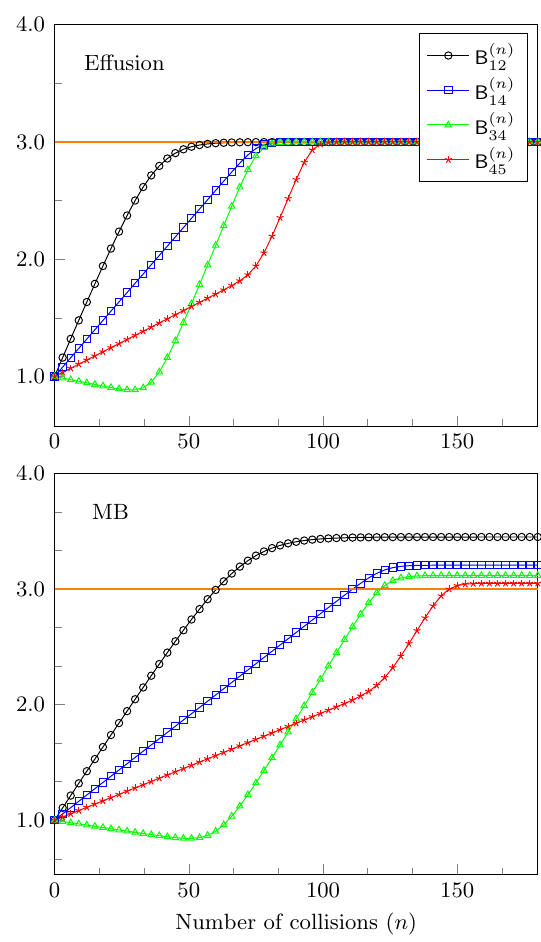
FIG. 6. Evolution of ρ ( n ) when the state of X is a mixture of Y broad Gaussian wave packets weighted with the effusion distribu- FIG. 5. Plot of B ( n ) defined in Eq. (58) computed for an ensem- jk ble of narrow Gaussian wave packets weighted by the effusion are obtained by composing tion. Upper panel: The values (ρ Y ) ( n ) ij distribution in Eq. (45) and the Maxwell-Boltzmann (MB) distri- and (ρ Y ) ( n ) in blue, while the map S Y . In black we depict (ρ Y ) ( n ) 11 22 bution (upper and lower panel, respectively) with β = 3. In both the real and imaginary parts of (ρ Y ) ( n ) are depicted in green (cid:8) H 12 cases, the initial state is the thermal state e − β Y / Z Y with β (cid:8) = 1 and red, respectively. Lower panel: The iterated map is given and the mass of the wave packet is m = 0.5. The orange line cor- in Eq. (5) with random Poissonian times τ i . In both panels: The responds to β = 3. For clarity, not all pairs of indices ( j , k ) are orange lines indicates the thermal values (ρ Y ) 11 and (ρ Y ) 22 with plotted. inverse temperature β . The light blue lines indicate the ther- mal values (ρ Y ) 11 and (ρ Y ) 22 with inverse temperature β C . The gray lines indicate the values (ρ Y ) 11 and (ρ Y ) 22 computed by considering the master equation for the populations ruled by W = S kk = 0.3 as given in Eq. (59). The initial state is (ρ Y ) ( 0 ) ik ii 11 = 0. The remaining parameters are (cid:8) = m = 0.5 and (ρ Y ) ( 0 ) Y 12 with e 2 = 2.5, e 1 = 2, σ = 0.31 and β =